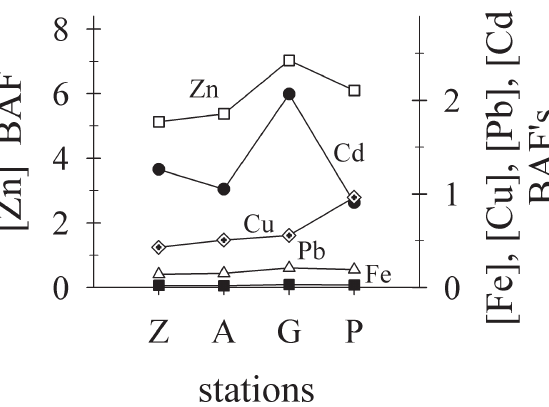
Fig . 4. – Bioaccumulation factor (ratio between metal concentra- tion in tissue [ Me ] and sediment [ Me ] - BaF) in the M. sanguinea t s population in Águas de Moura channel.